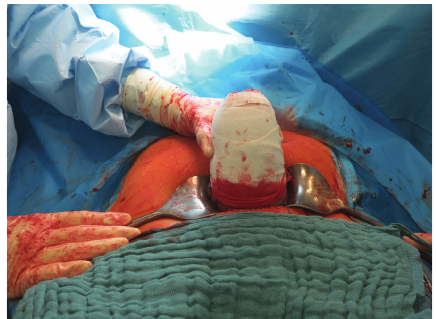
Figure 1: Wrapped uterus in case 2 .